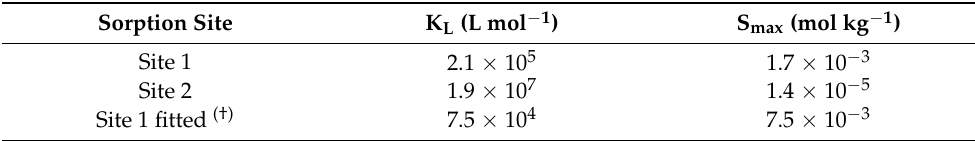
Table 3. Langmuir isotherm parameters from Frasca et al. [18] used in the Se(IV) sorption model for Opalinus Clay. These parameter values are used in Equation (2) to represent Se(IV) sorption using a 2-site Langmuir isotherm. K L is the sorption potential and S max is the sorption capacity of each site. Sorption